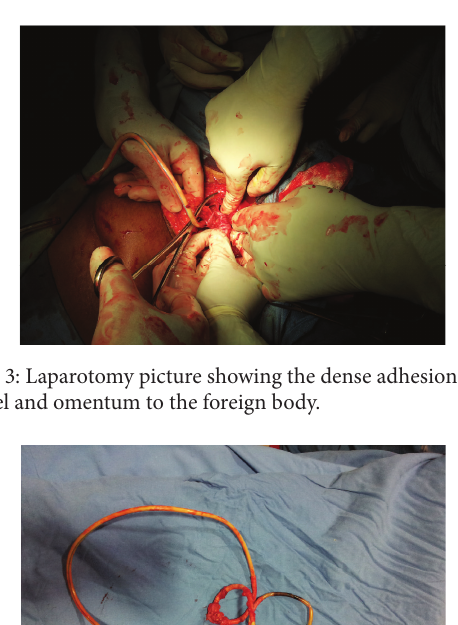
Figure2:StraightX-rayPAviewoftheabdomenandpelvisshowing the coiled foreign body occupying the pelvis and lower abdomen with three radiolucent beads at one end.